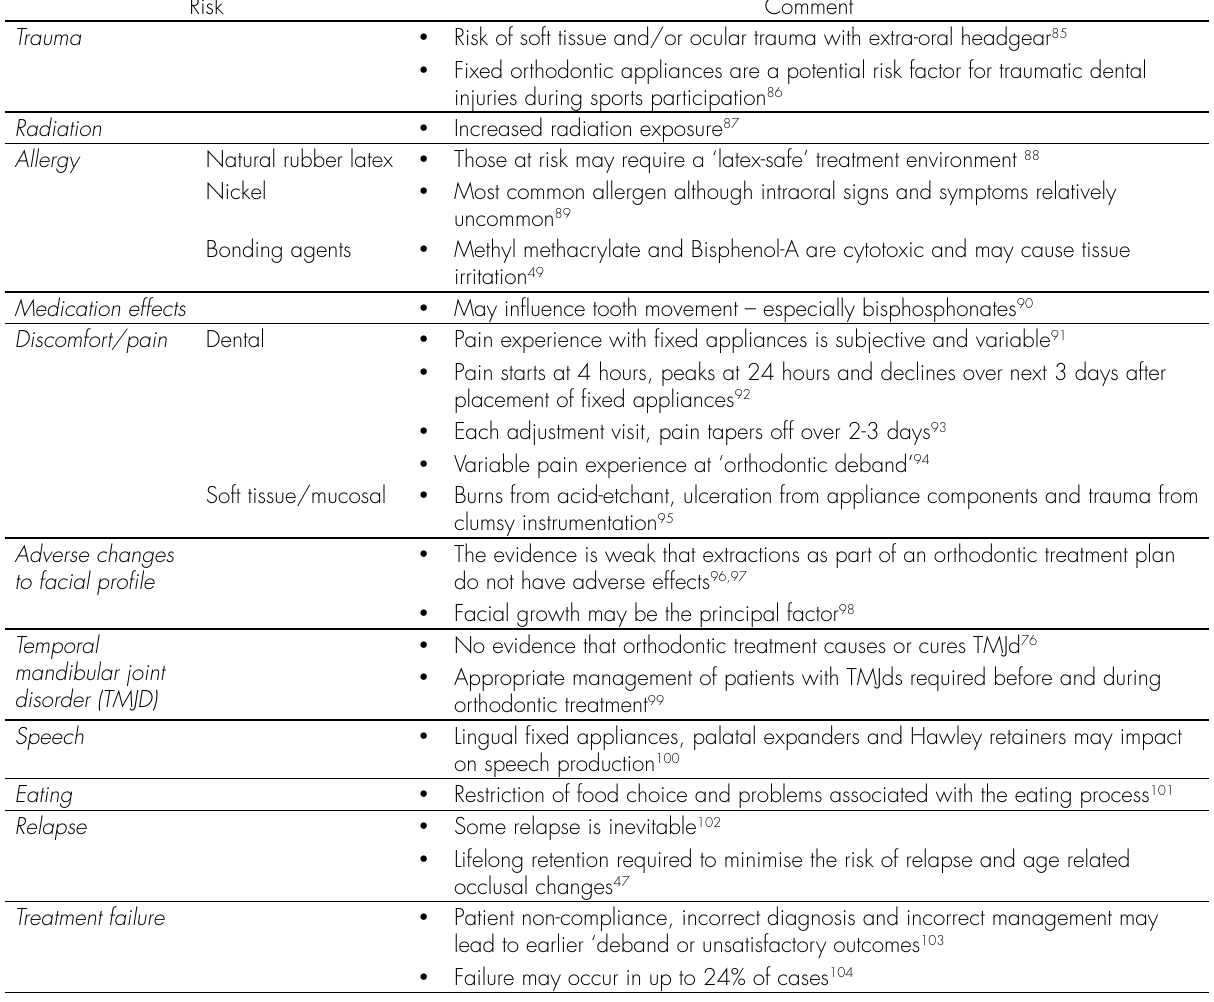
Table II. Summary of the main proposed general risks of orthodontic